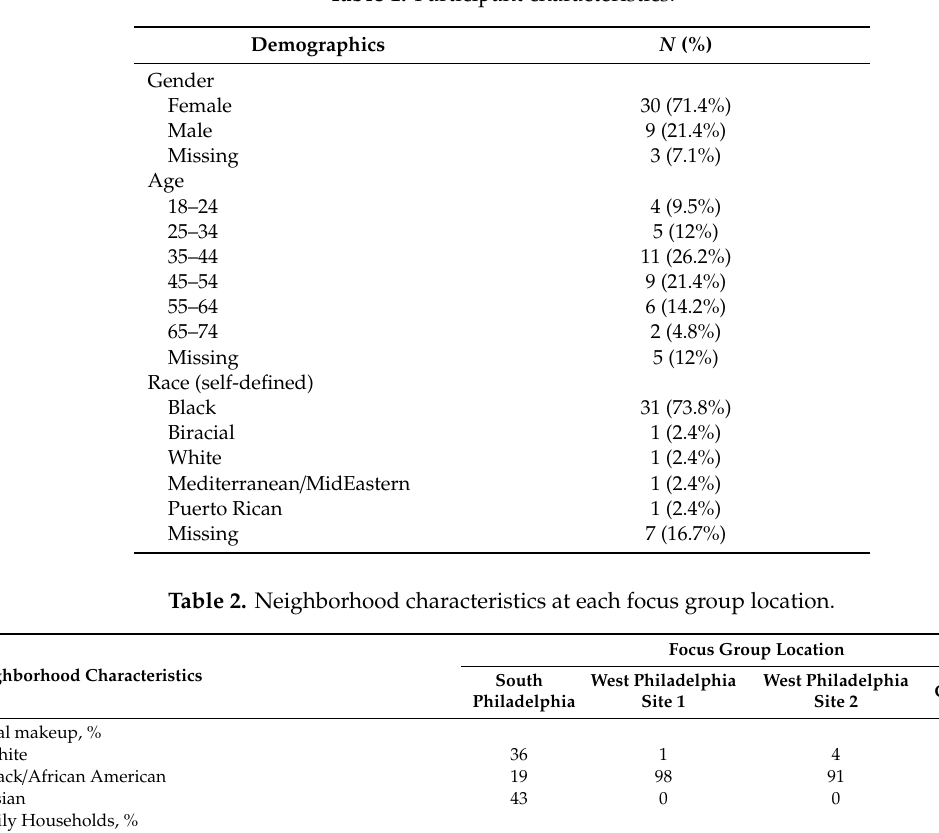
Table 1. Participant characteristics.